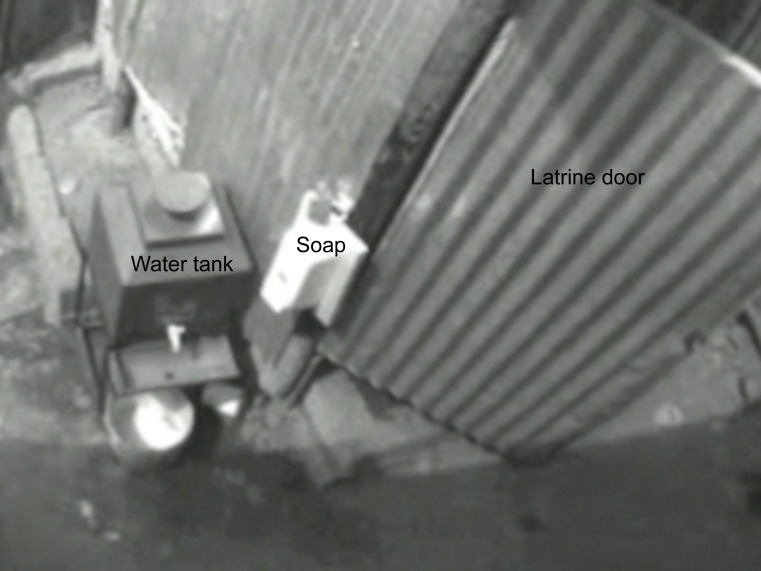
Still frame from a camera positioned above a handwashing with soap station next to a latrine (door is open).